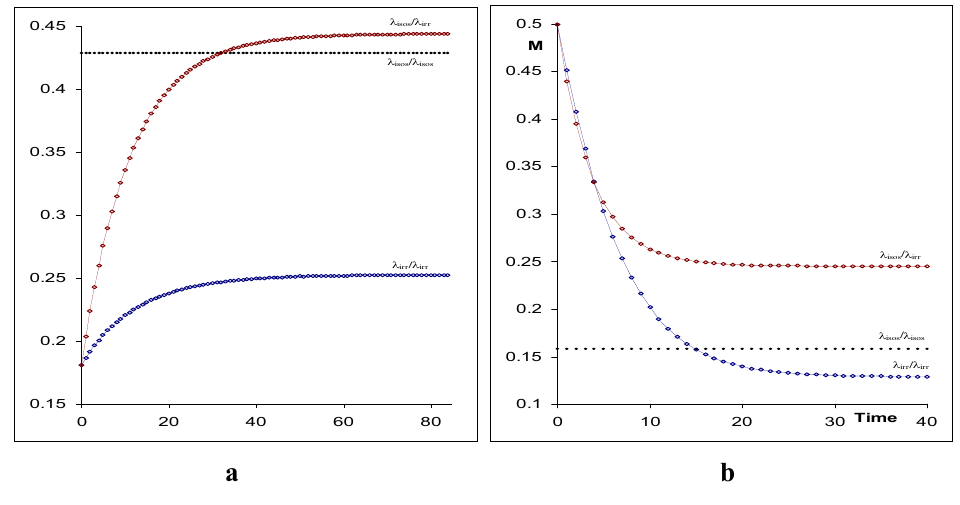
Figure 10 : Examples of simulated (a) AB(1k,2 φ ) kinetic traces using RK integration for the photochemical reaction performed at two excitation conditions (here at exc/irr wavelength, irr Airr ε>ε ) and (b) AB(2 φ ) photoreaction ( irr Birr B wavelength) [reprinted from Ref. 94 with permission of Photochemical and Photobiological